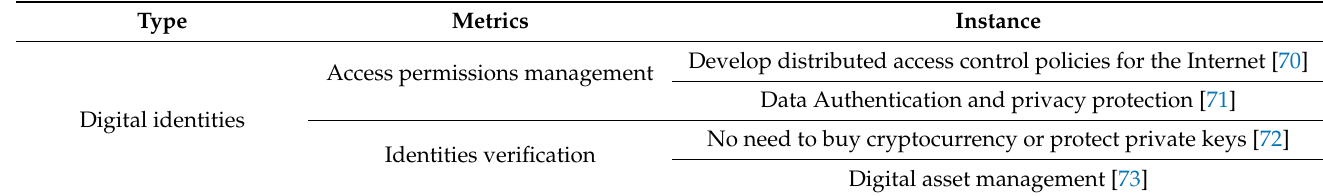
Table 2. Metrics for application of blockchain middleware in